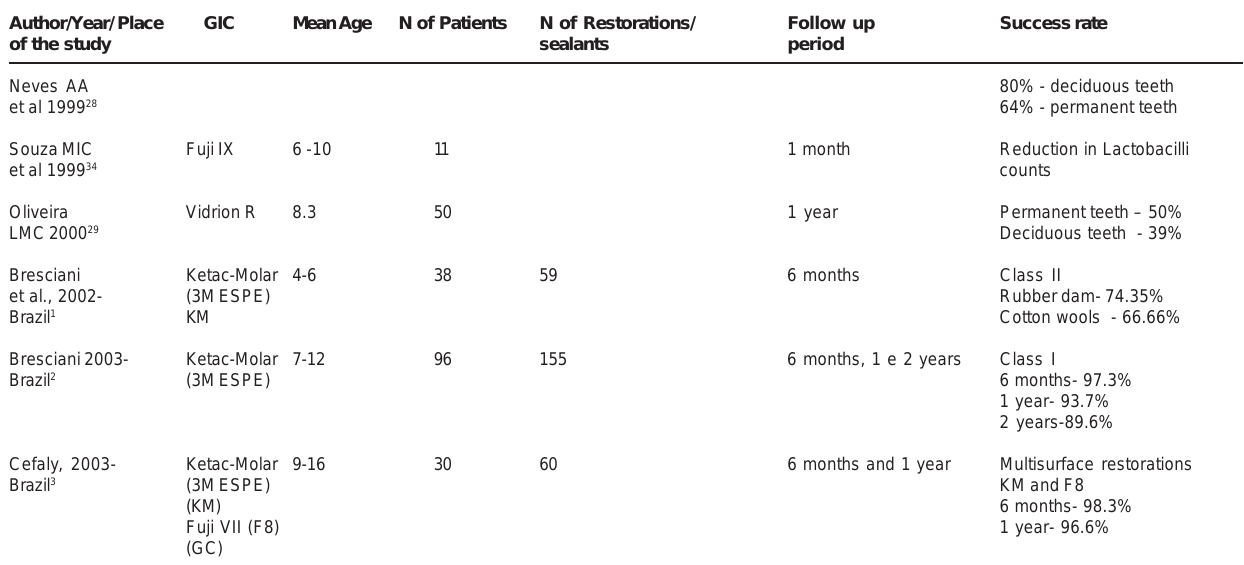
TABLE 2- Clinical studies searched at LILACS at June 1 st , 2004